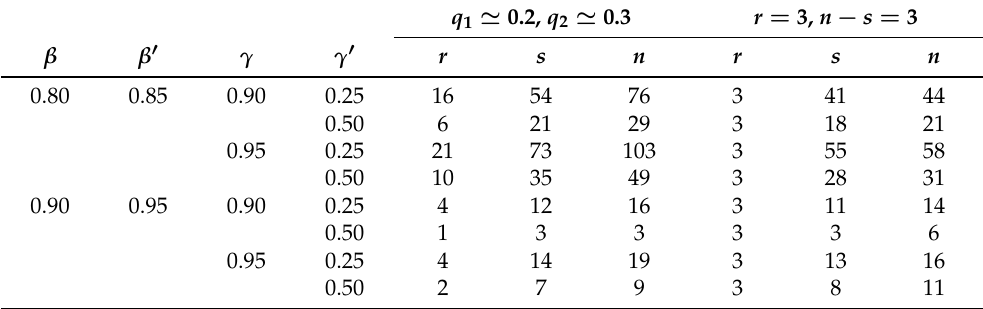
Table 2. Optimal sampling plans ( r , s , n ) for setting lower ( β , γ ) -TLs for the W ( α , θ ) model based on X = ( X r : n ,..., X s : n ) when (i) q 1 (cid:39) 0.2 and q 2 (cid:39) 0.3 and (ii) r − 1 = 2 and n − s =